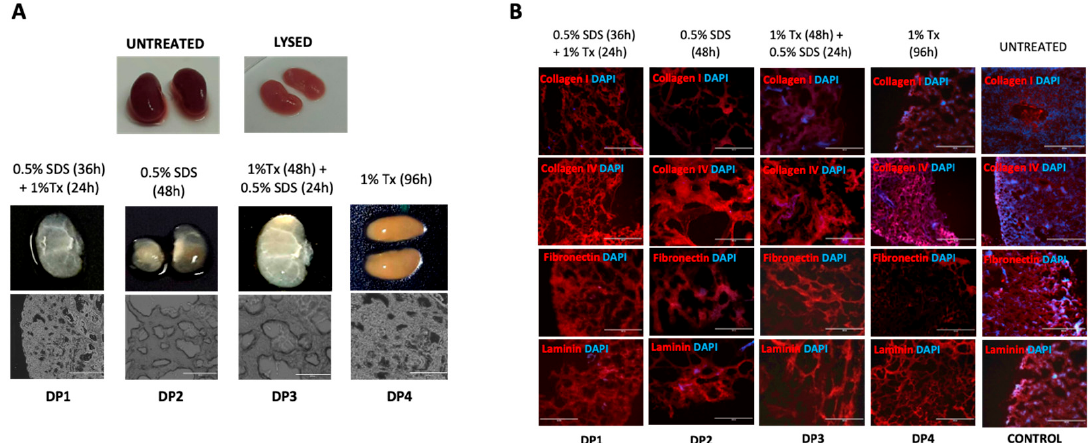
Figure 1. ( A ) Optical and light microscopy of native and decellularized murine kidneys. Four different decellularization conditions using combinations of Sodium Dodecyl Sulphate (SDS) and Triton-X100 (Tx) followed by DNase (Benzonase ® nuclease) digestion (decellularization protocols (DP) 1–4) were used to decellularize mouse kidneys compared with non-decellularized kidney (UNTREATED) and kidneys subjected to a cellular lysis treatment involving ddH 2 O immersion for 4 h (LYSED). The conditions used in each DP were as follows: DP1—0.5% SDS (36 h) + 1% Tx (24 h); DP2—0.5% SDS (48 h); DP3—1% Tx (48 h) + 0.5% SDS (24 h) and DP4—1% Tx (96 h). Shown are macroscopic images of whole (UNTREATED and LYSED) and sliced decellularized kidneys (DP1–4), and additionally for DP1–4 samples, light micrographs of the decellularized kidney tissues (lower panels). ( n > 3 per experiment), Scale bar: 400 µ m; Magnification: 10 × ; ( B ) Immunofluorescence of extra-cellular matrix proteins post-decellularization. Preservation of collagen I, collagen IV, fibronectin and laminin following decellularization of murine kidney slices by varied combinations of SDS and/or Triton-X100 was assessed. Untreated murine kidneys served as negative controls. ( n > 3 per experiment).